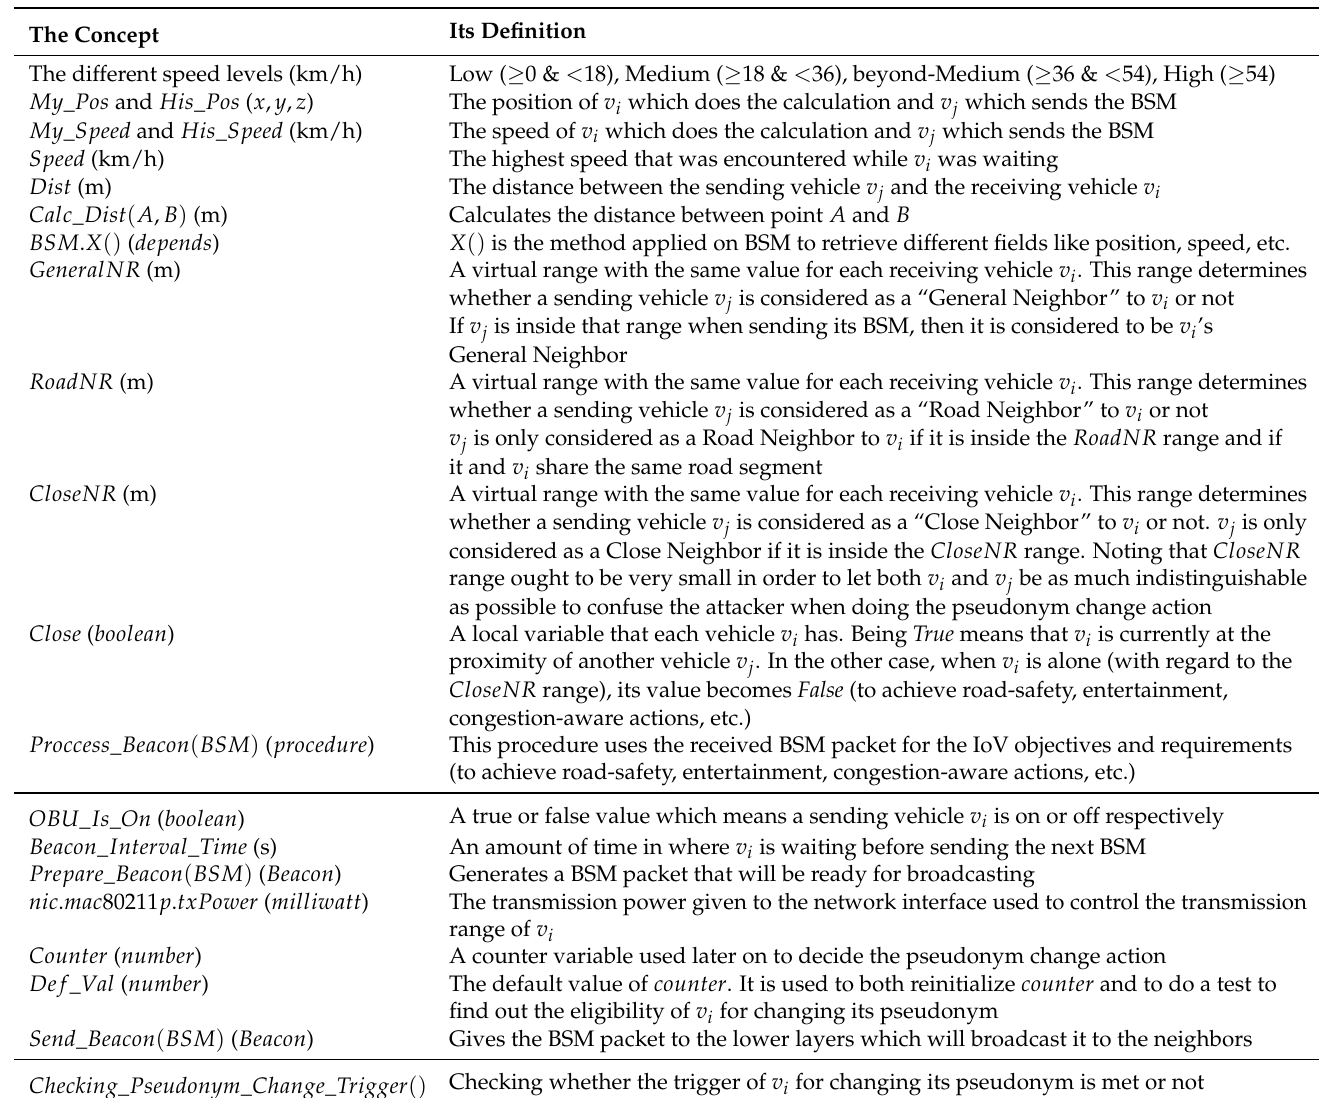
Table 2. WHISPER keywords, concepts, and detailed